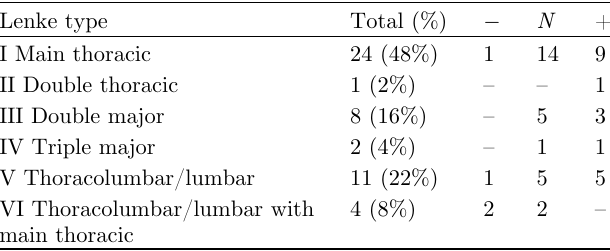
Figure 2. Female patient 16 years old with Lenke 5 c +. (A) Preoperative X-rays showing lumbar curve of 56 ° that was corrected to 41 ° and main thoracic curve of 28 ° that was corrected to 20 ° in side bending films, with thoracic kyphosis of 48 ° . (B) Two years postoperative X-rays showing posterior correction and fusion of the lumbar curve only from T9-L5 with lumbar curve correction to 10 ° and spontaneous main thoracic curve correction to 14 ° with thoracic kyphosis of 38 ° . Table 1. Classification according to